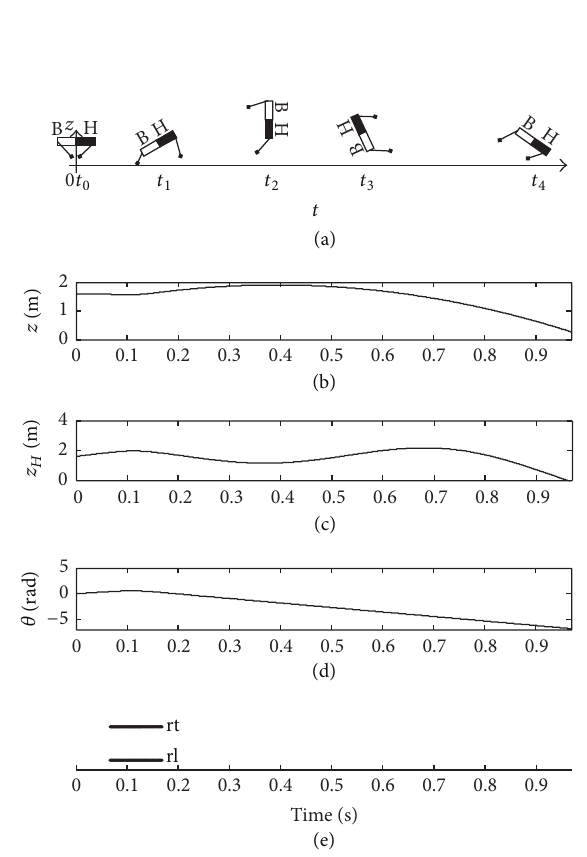
Figure 8: Balance posture of trunk with 𝛽 td rt = 0 . 32 rad.